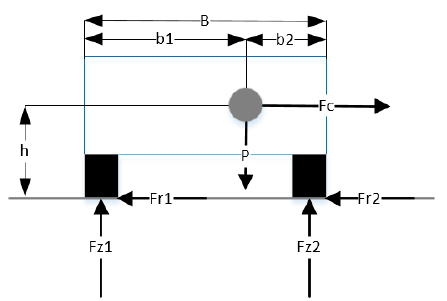
Figure 29. Application of centrifugal force. Frontal view.